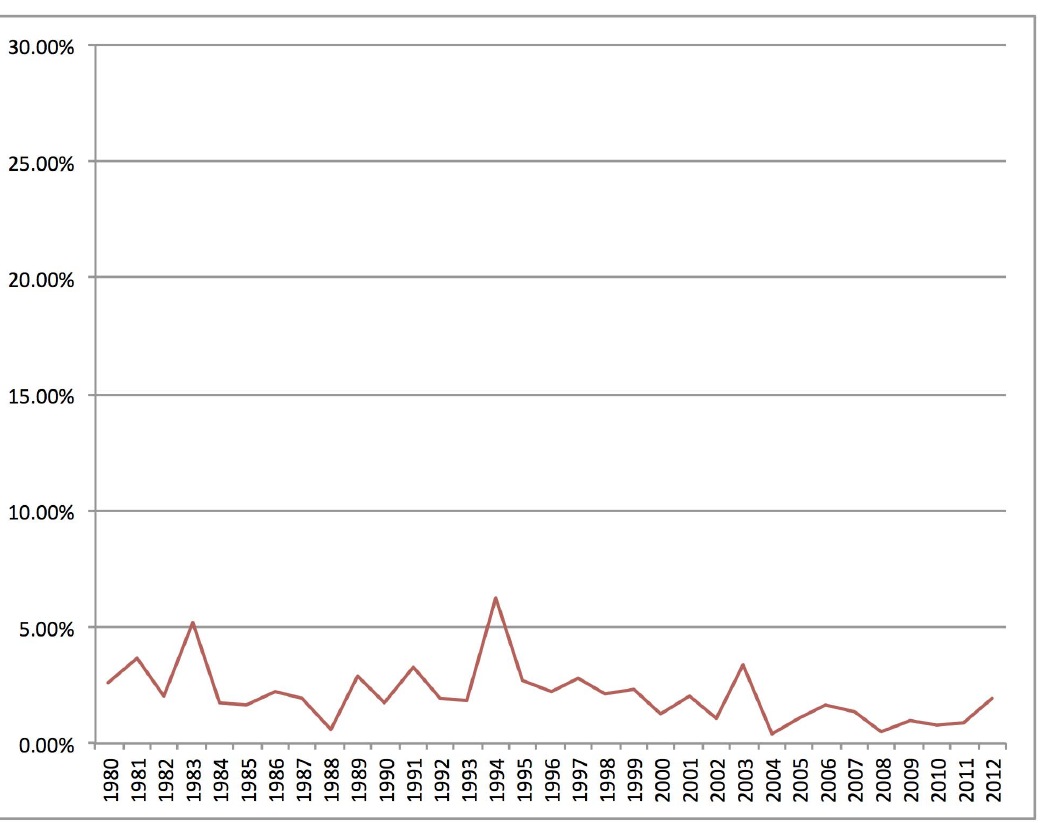
Figure 7. Prominence of race in demarcation corpus over time. Percentage of documents in each year with at least 15% race content.